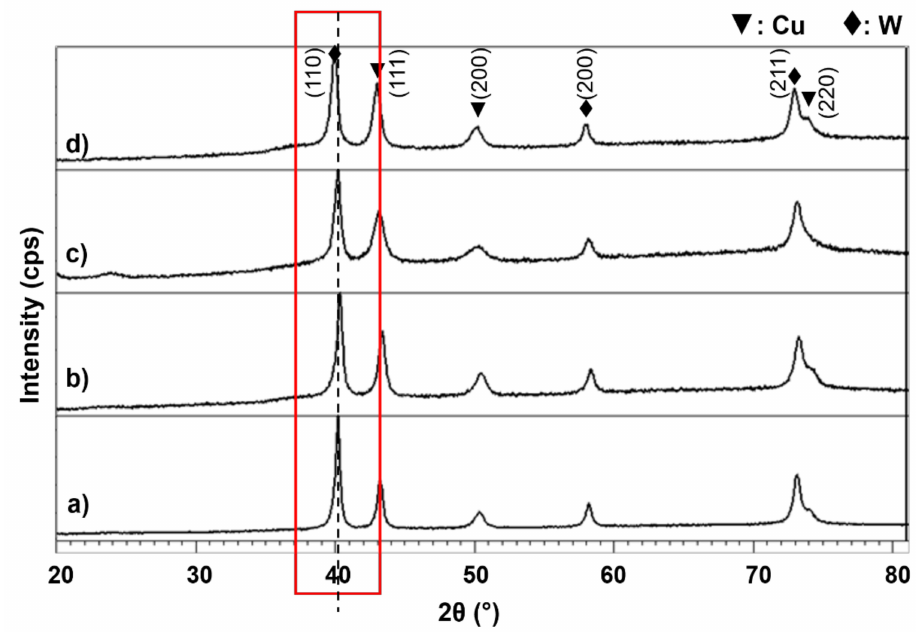
Figure 1. XRD patterns of the composite milled for ( a ) 10 h, ( b ) 20 h, ( c ) 40 h and ( d ) 60